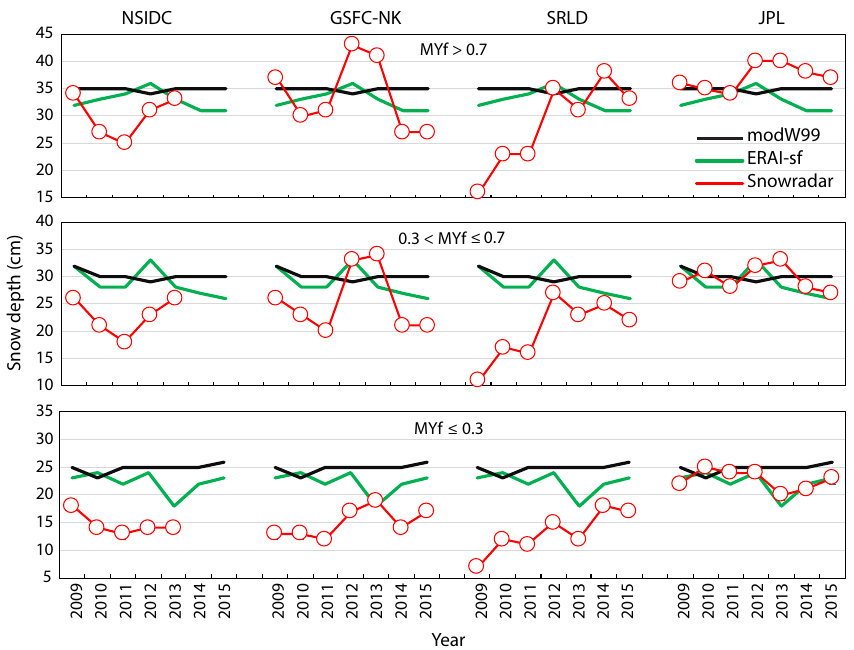
Figure 11. Comparison of snow depth retrievals from four algorithms (NSIDC, GSFC-NK, SRLD, JPL) with ERAI-sf and modW99 estimates in three multiyear/seasonal ice regimes (MYf ≥ 0.7; 0.3 < MYf < 0.7; MYf ≤